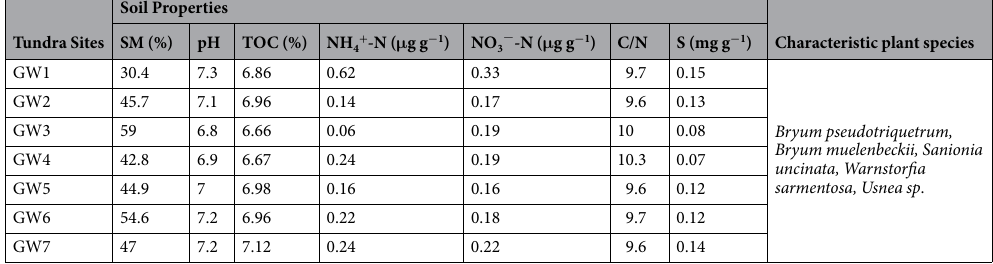
Table 1. Soil properties and plant species at the sites for the upland tundra in maritime Antarctica. Note: SM, TOC and C/N indicated soil moisture, total organic carbon and the ratios of soil organic carbon and nitrogen, respectively.